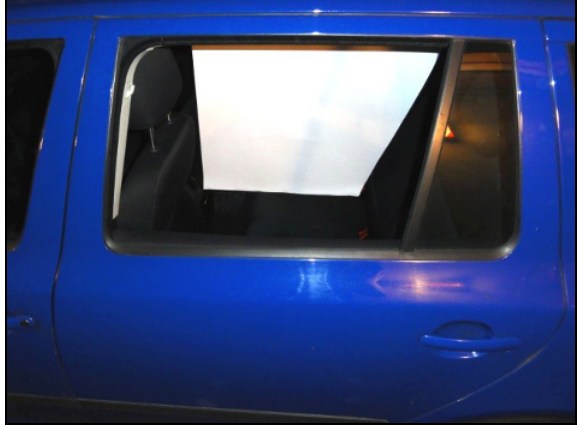
Fig. 5. Auxiliary material position before the mouth outlet of rear seats